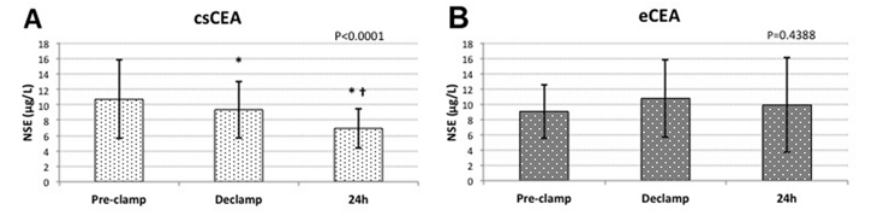
Fig 1. Variations of NSE serum concentrations within groups. (A) csCEA group; (B) eCEA group; * — significant compared to pre-clamp (P < 0.01); † - significant compared to declamp (P < 0.05)